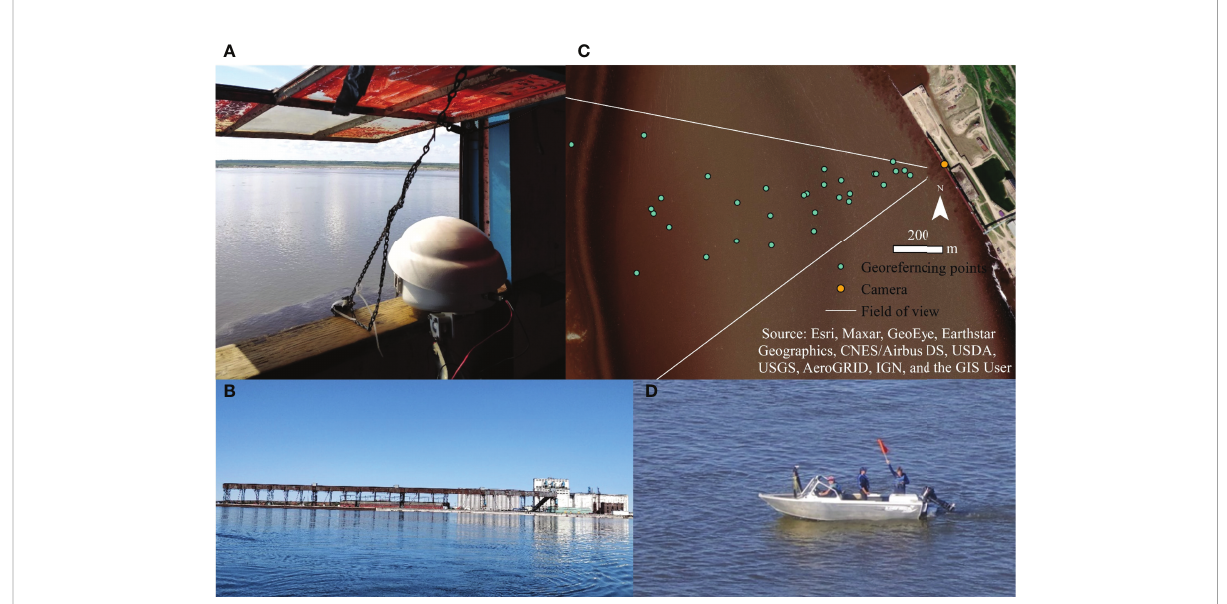
FIGURE 2 (A) Digisnap Pro Cyclapse system. The camera is under the white dome necessary to protect the camera from rain. (B) The Port of Churchill gallery (two-story structure) where the camera is located, as viewed from the estuary. (C) Location of georeferencing points on the estuary (white lines represent the fi eld of view of the camera). (D) Image of a georeferencing point being